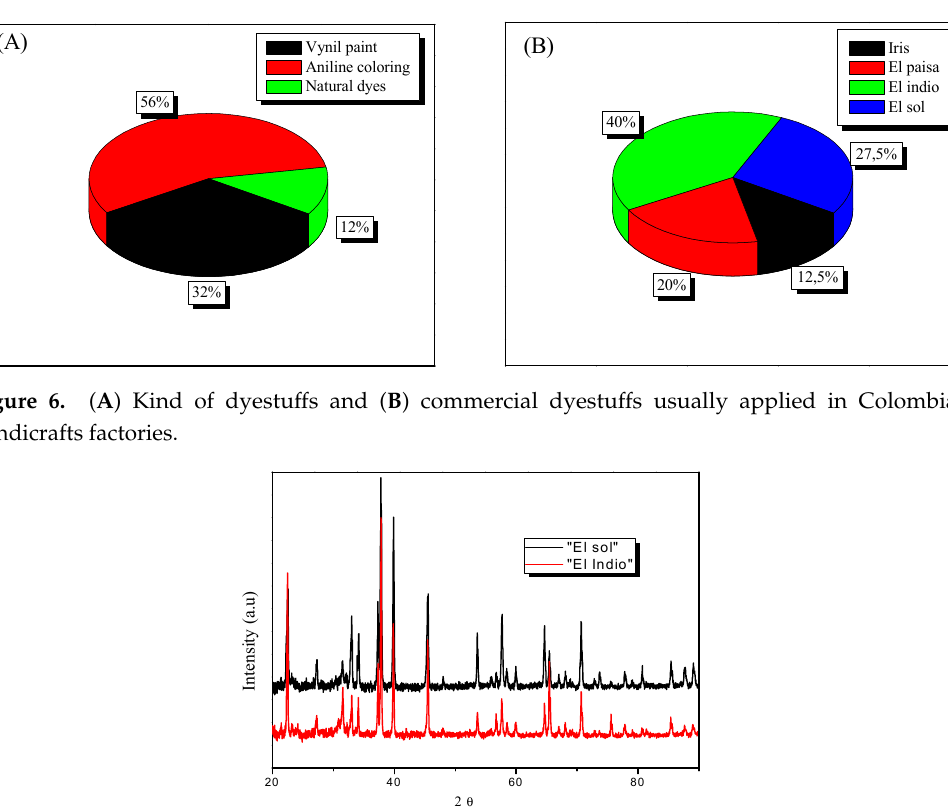
Figure 6. ( A ) Kind of dyestuffs and ( B ) commercial dyestuffs usually applied in Colombian handicrafts factories.